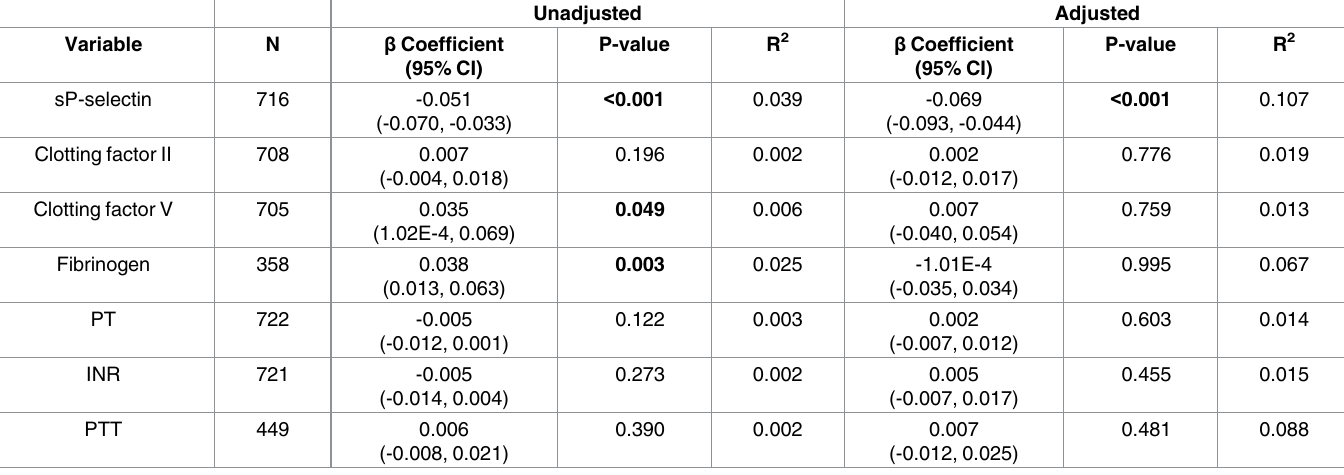
Table 2. Association of δ 15 N values with coagulation variables using multivariate regression analysis.